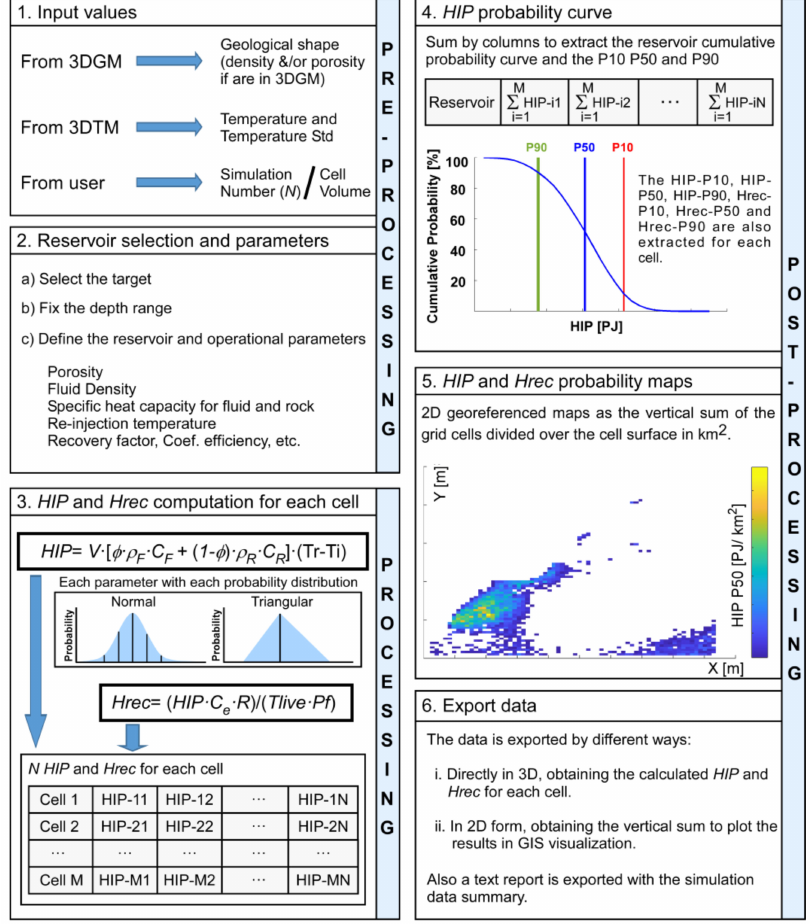
Figure 2. 3DHIP-Calculator workflow. It is divided into six main steps: (1) input values, (2) reservoir selection and parameters, (3) HIP and Hrec computation, (4) HIP probability curve, (5) HIP and Hrec probability maps, and (6) export data (modified from Herms et al., 2021